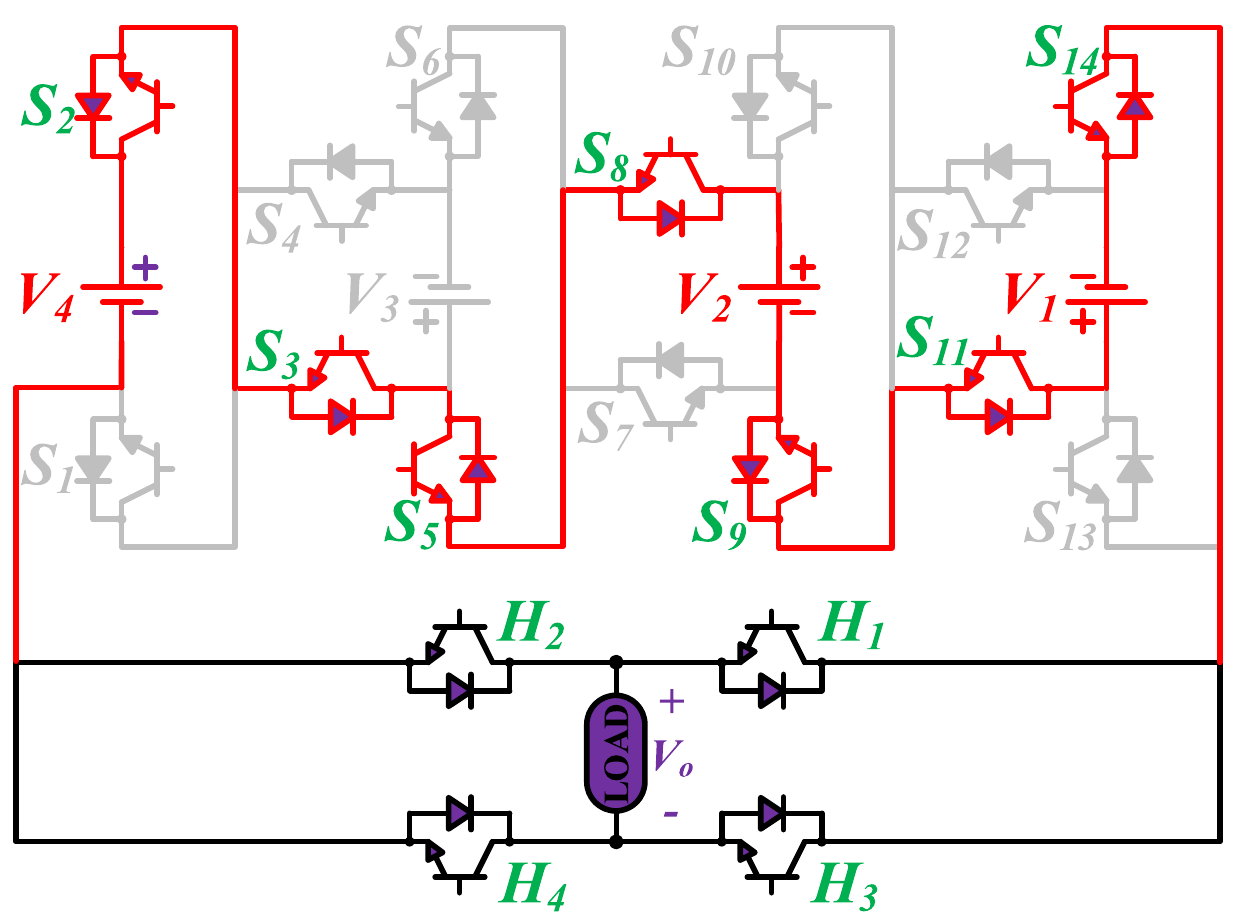
Fig 9. Switching states for voltage magnitude level